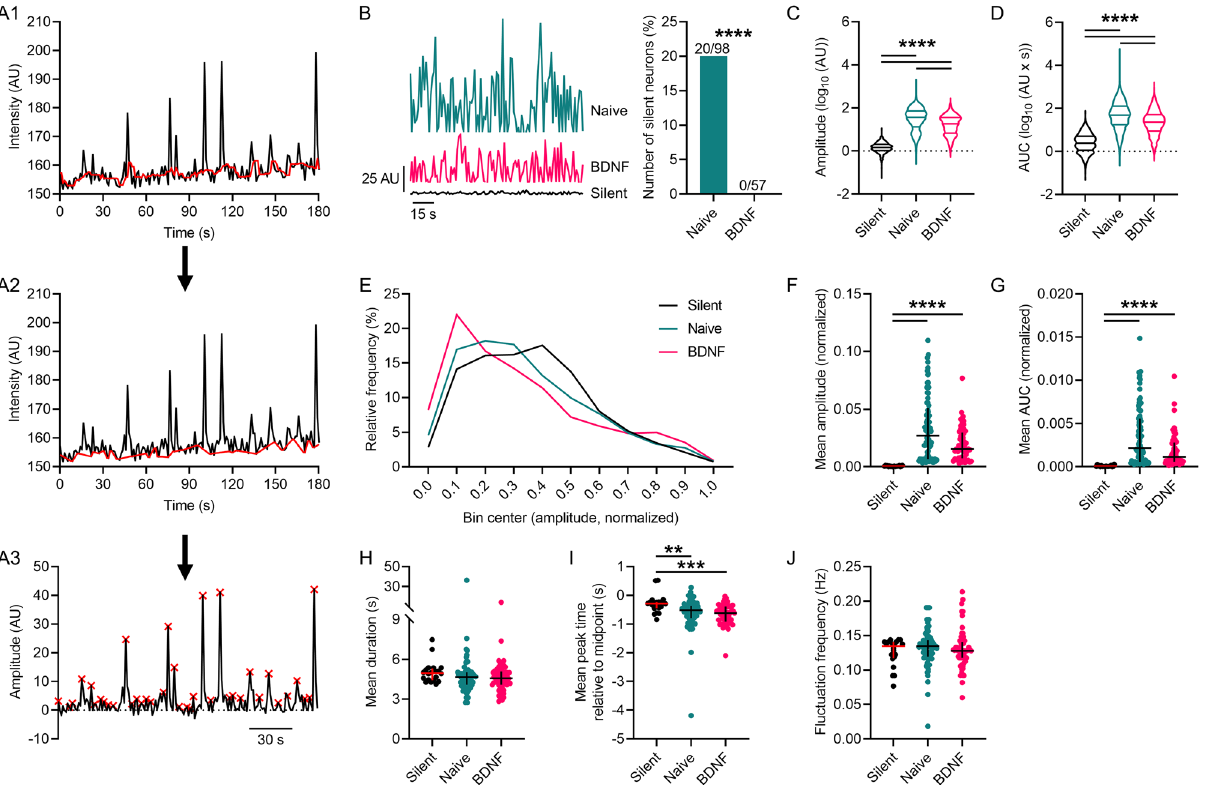
Figure 1. BDNF-induced fluctuations of [Ca 2+ ] I in superficial dorsal horn neurons. ( A1 – A3 ) Example recording [Ca 2+ ] i fluctuations sampled in a SDH neuron and the processing steps used by the FIBSI event- detection program. The running median (red line in A1, window = ~ 5 s) was calculated based on the raw amplitude (AU) and time coordinate data, then the peaks below the running median were traced to form a reference line (red line in A2), and then the Ramer–Douglas–Peucker algorithm detected waveforms above the reference (red x at event peaks). ( B ) Left: Examples of [Ca 2+ ] i activity detected by FIBSI in 3 different neurons. Right: The proportion of ‘silent’ neurons in the BDNF-treatment condition was significantly reduced compared to the naïve condition. Proportions were compared using a Fisher exact test. ( C , D ) Violin plots of the log- transformed values for fluctuation amplitude and AUC. Fluctuation amplitudes and AUC were significantly increased in naïve and BDNF-treated neurons compared to the ‘silent’ neurons, while both measures in the BDNF-treated neurons were significantly reduced compared to naïve. Neurons sampled: ‘silent’ n = 20 (849 fluctuations), naïve n = 78 (2651 fluctuations), and BDNF n = 57 (1555 fluctuations). Median with quartiles shown. Comparisons made using Brown-Forsythe and Welch’s ANOVA tests and Games-Howell post-hoc test. ( E ) Relative frequency (%) of the fluctuations binned by amplitude. Amplitude values were normalized to the largest fluctuation in each neuron. ( F – G ) The mean fluctuation amplitude and AUC in the naïve and BDNF- treated neurons were significantly increased compared to the ‘silent’ neurons. ( H – J ) Further analysis revealed little to no effect of BDNF on fluctuation duration or frequency, but the fluctuations in ‘silent’ neurons exhibited longer rise times. For scatterplots F–J, the fluctuations that were < 10% the maximal fluctuation amplitude in each neuron were omitted to reduce the effects of low-amplitude noise. Scatterplots in F–J show the median with the interquartile range. All comparisons of medians in F–K were made using Kruskal–Wallis tests and